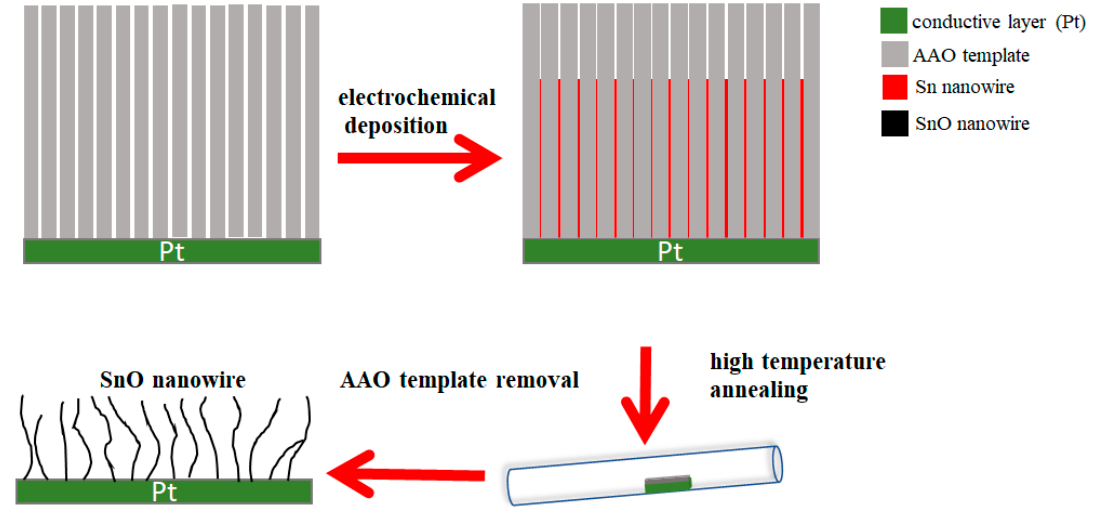
Figure 2. Schematic representation of the synthesizing procedure of SnO nanowires.